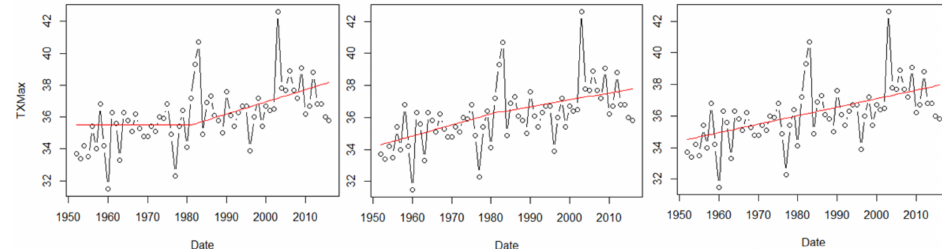
Figure 2. Orange Station: Annual maximum temperatures (over the period from 1952 to 2016) and the linear evolution of the expectation µ ( t ) + 0.577 σ (represented by the straight line). ( Left ) The model M 1 ( 1,0 ) with a linear trend after the break date; ( Middle ) the model M 2 ( 1,0 ) with a linear trend before and after the break date; ( Right ) the model M 3 ( 1,0 ) with a linear trend without a break